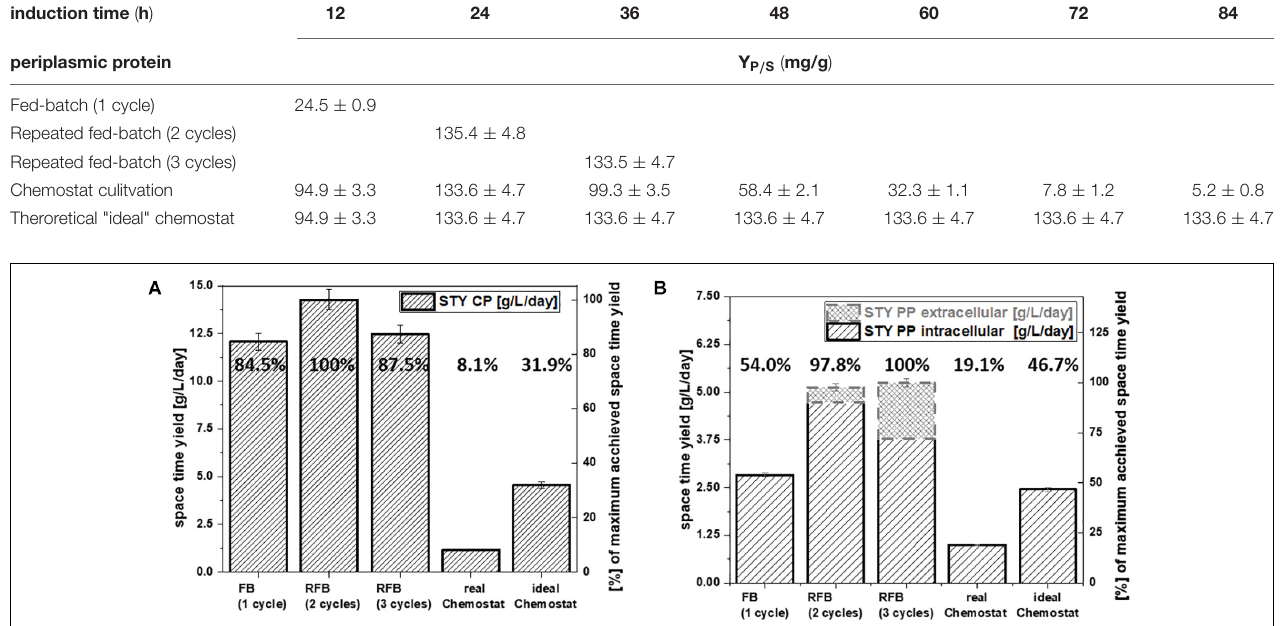
FIGURE 4 | Comparison of the overall space-time yield of each cultivation mode for (A) cytoplasmic protein expression and (B) periplasmic protein expression in g/L/day; percentages are calculated relatively to the highest space-time yield achieved for each target